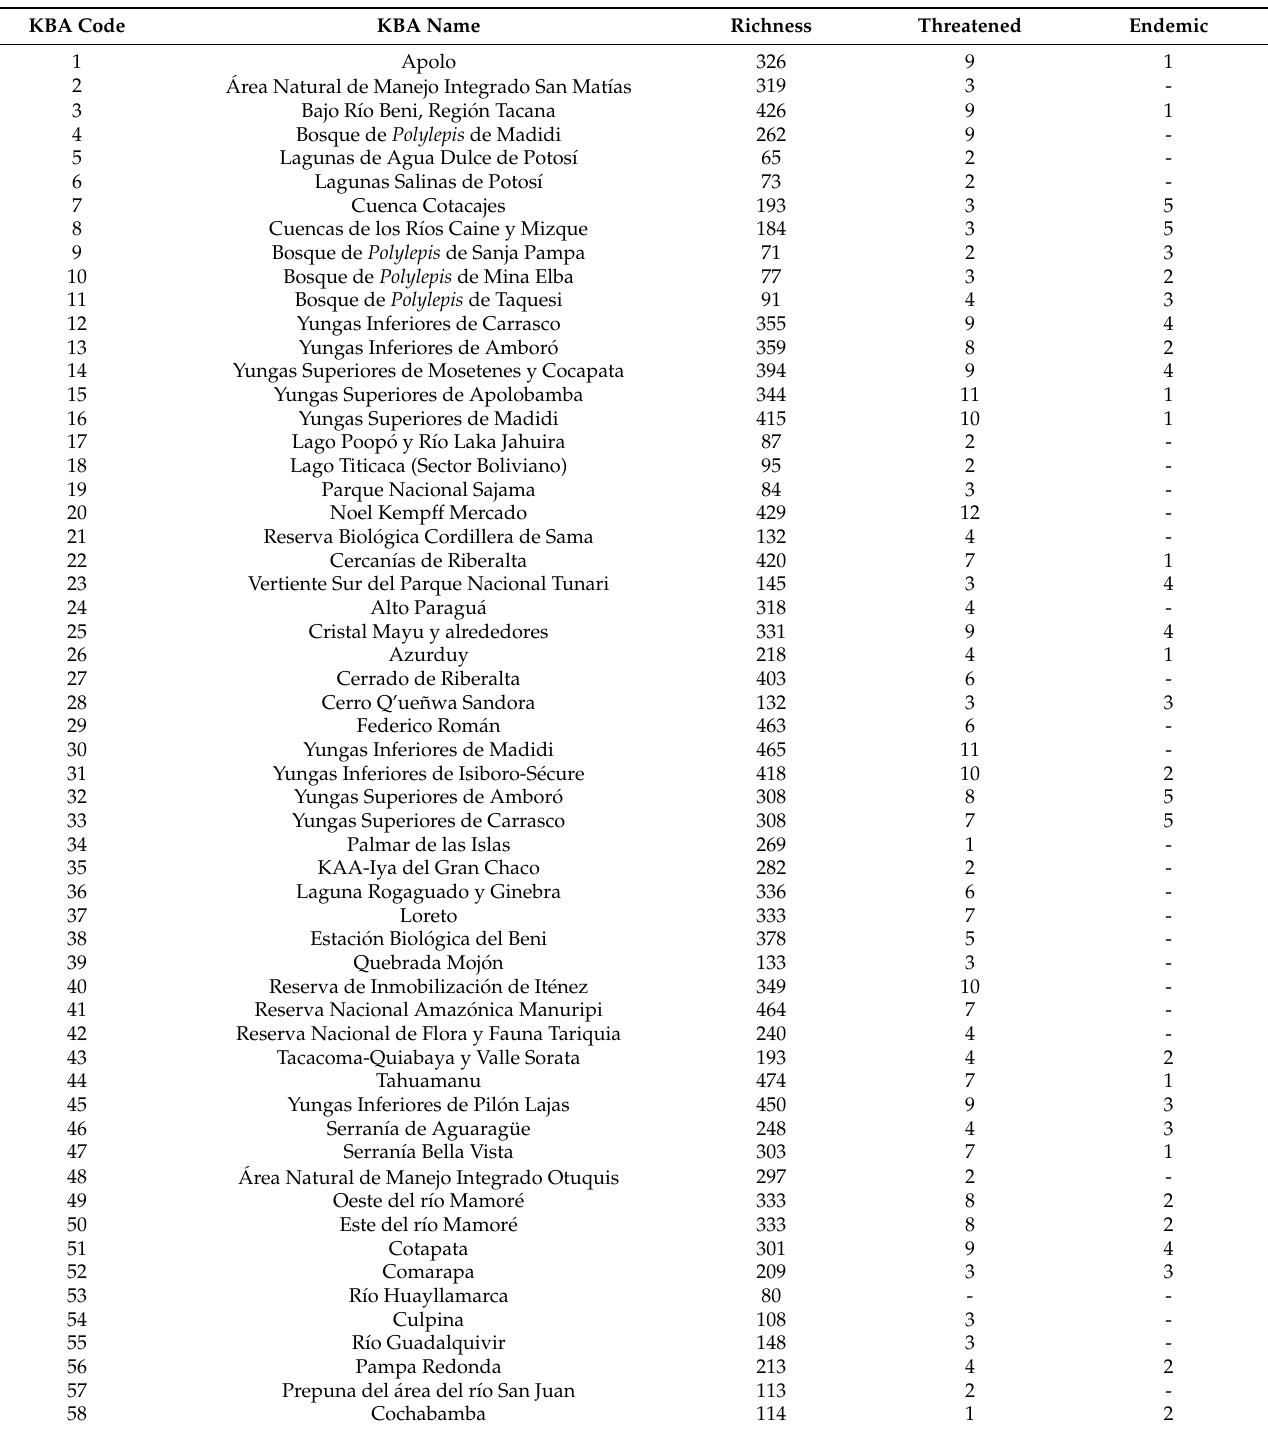
Table 1. Maximum pixel value of 1 (cid:48) × 1 (cid:48) for total, endemic and threatened bird richness in the KBAs of